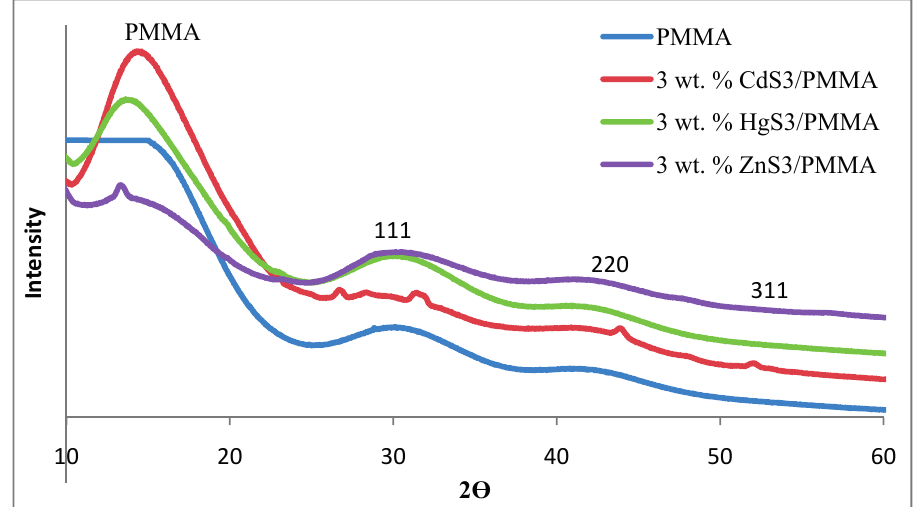
Figure 2. XRD diffraction patterns PMMA, ZnS/PMMA, CdS/PMMA and HgS/PMMA